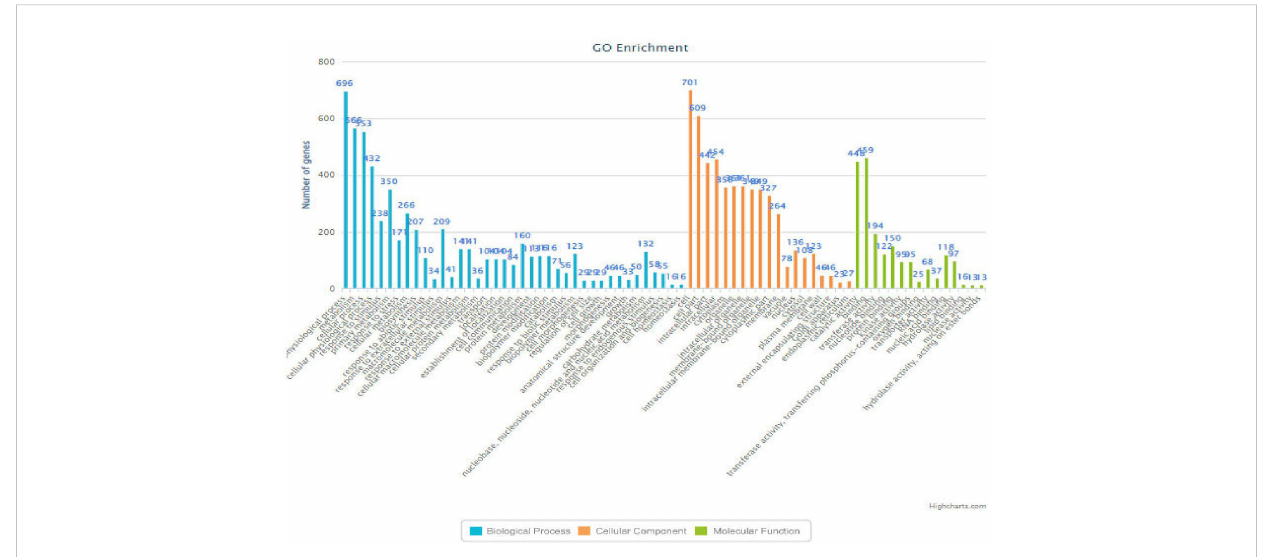
FIGURE 6 Bar-chart (RM6100) indicating the functions of the genes associated with various biological processes along with their frequency.